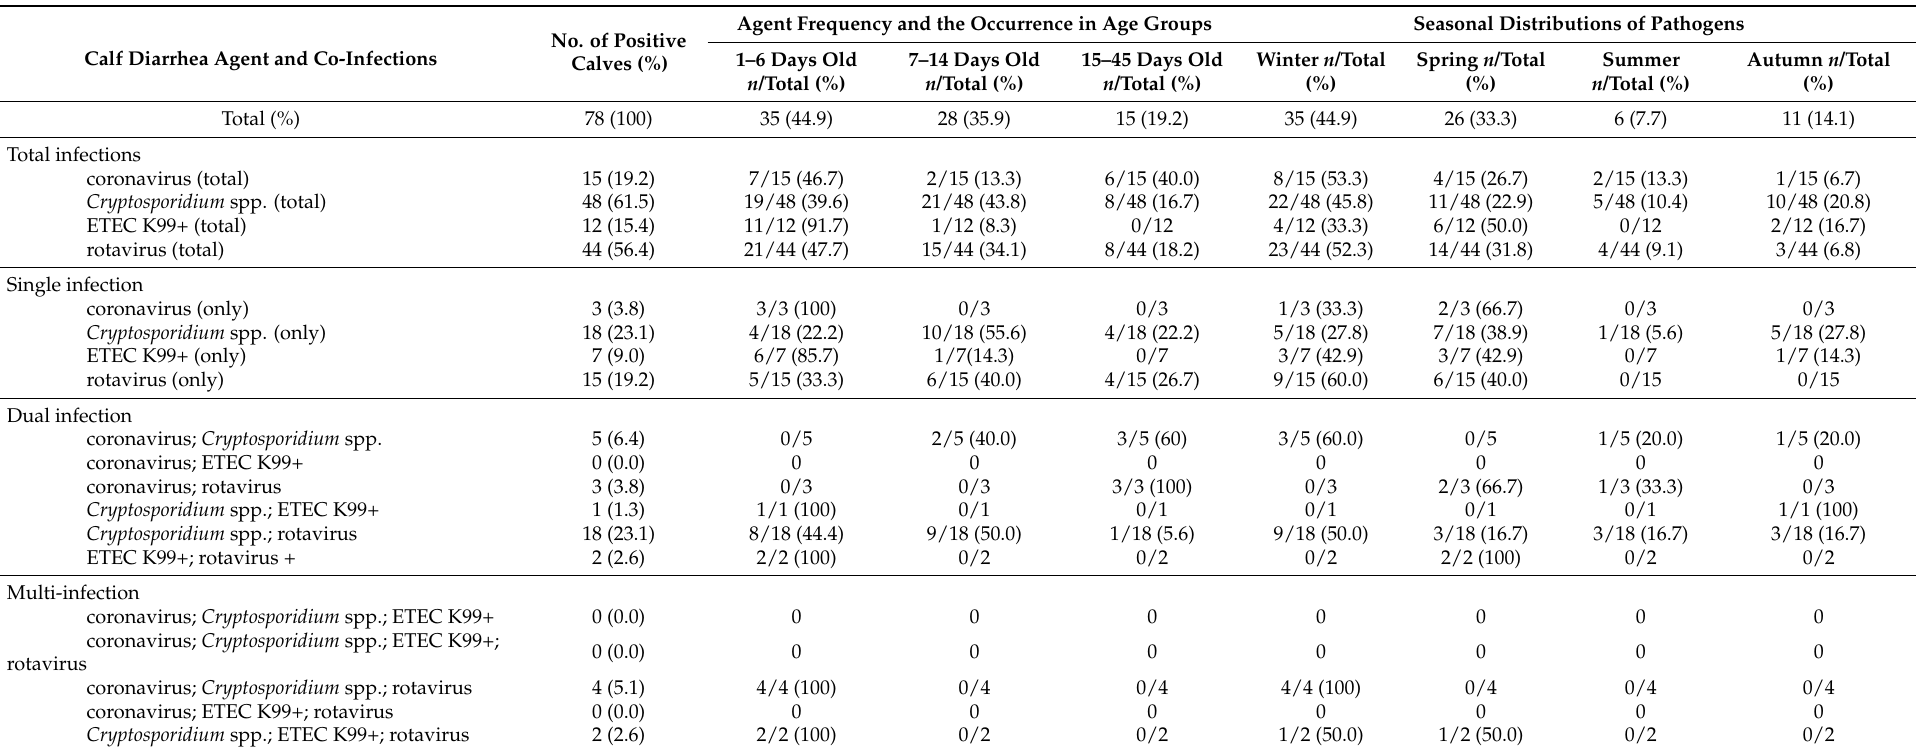
Table 2. Diarrhea-causing pathogens identified by PCR in feces sample from calves admitted to ICU by age groups, season, and infection status (single, dual, or multi-infections).